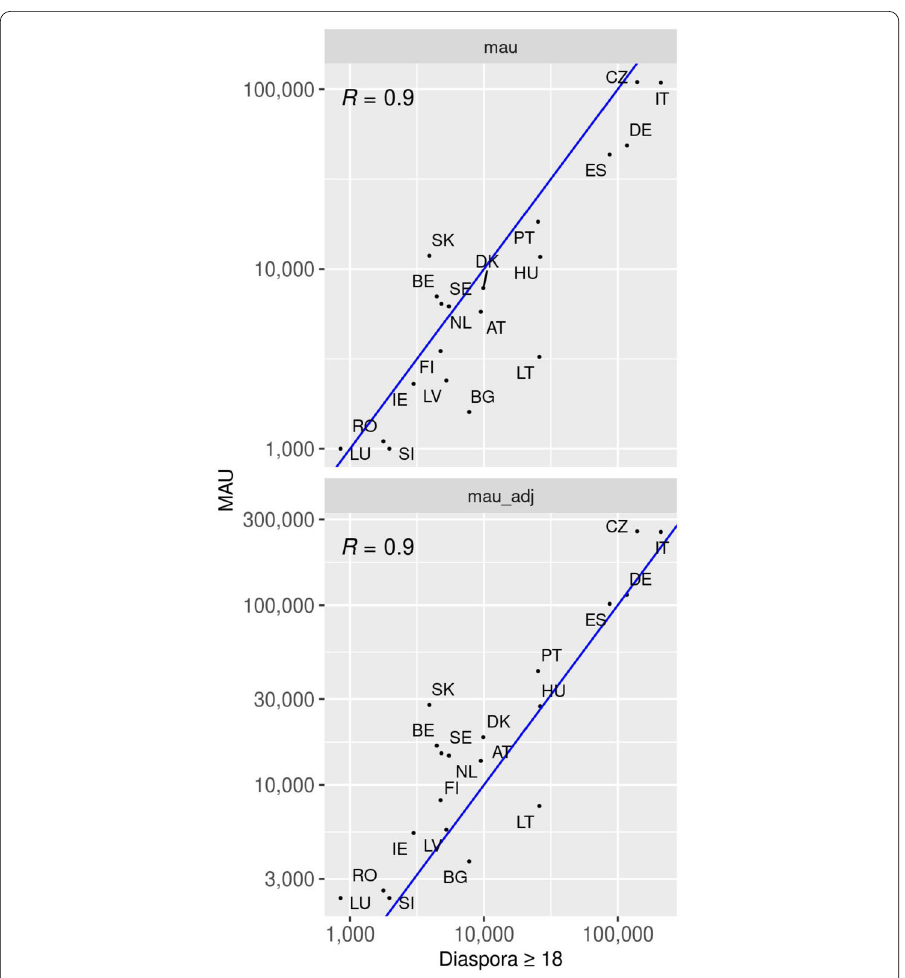
Figure 1 PrewarMAUsvsover18Ukrainiandiaspora . Scatter-plot (logarithmic scale) of prewar Facebook MAUs at national level against Ukrainian diaspora in 21 EU countries (official statistics relative to 2021). Upper plot: original MAUs. Lower plot: adjusted